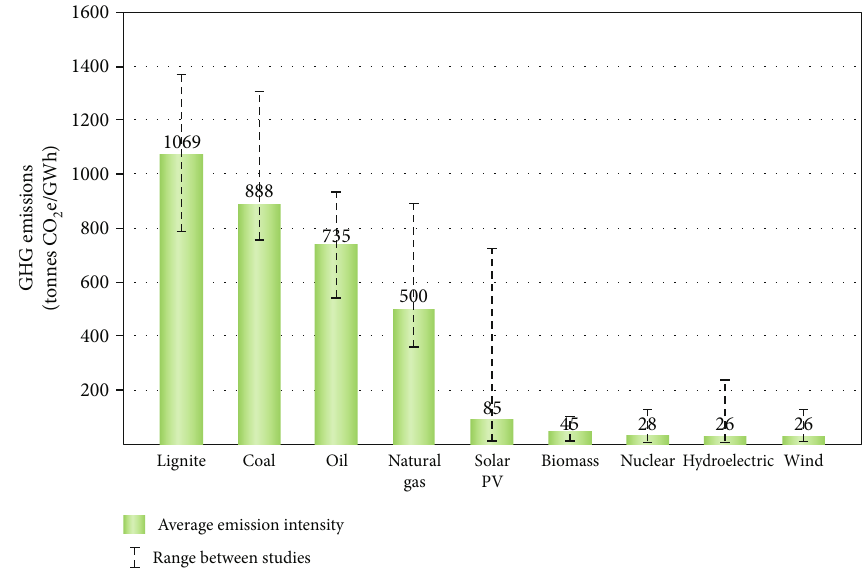
Figure 2: Lifecycle of greenhouse gas emission intensity of electricity generation method (source: